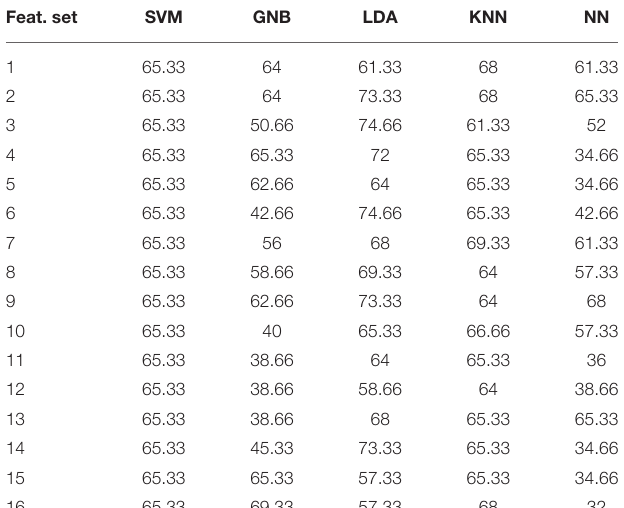
TABLE 5 | Performance of different models at different extracted features for phonation (P) modality obtained from SP channel. Feat.